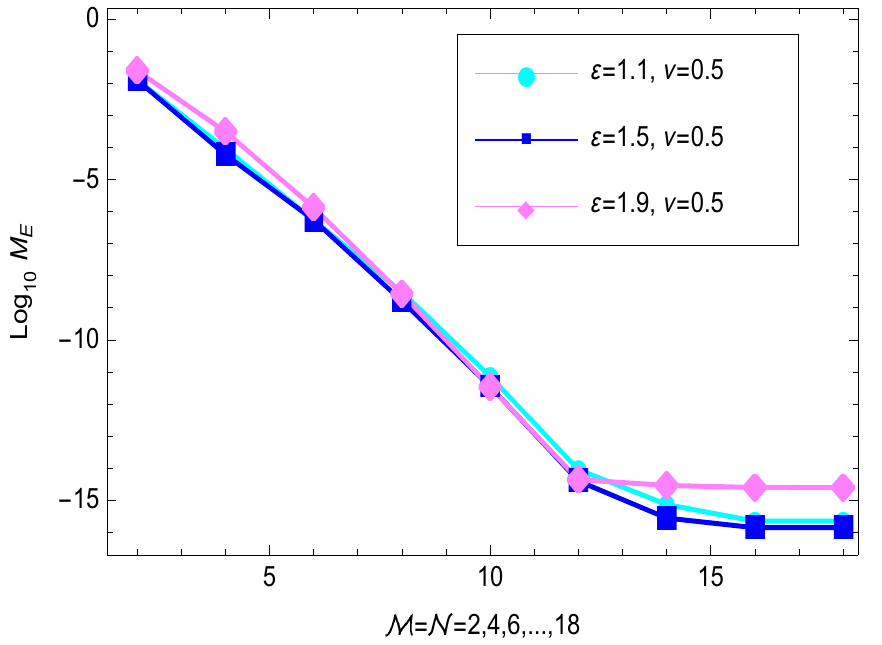
Figure 11. M E convergence of problem (18), for different values of ε and ν